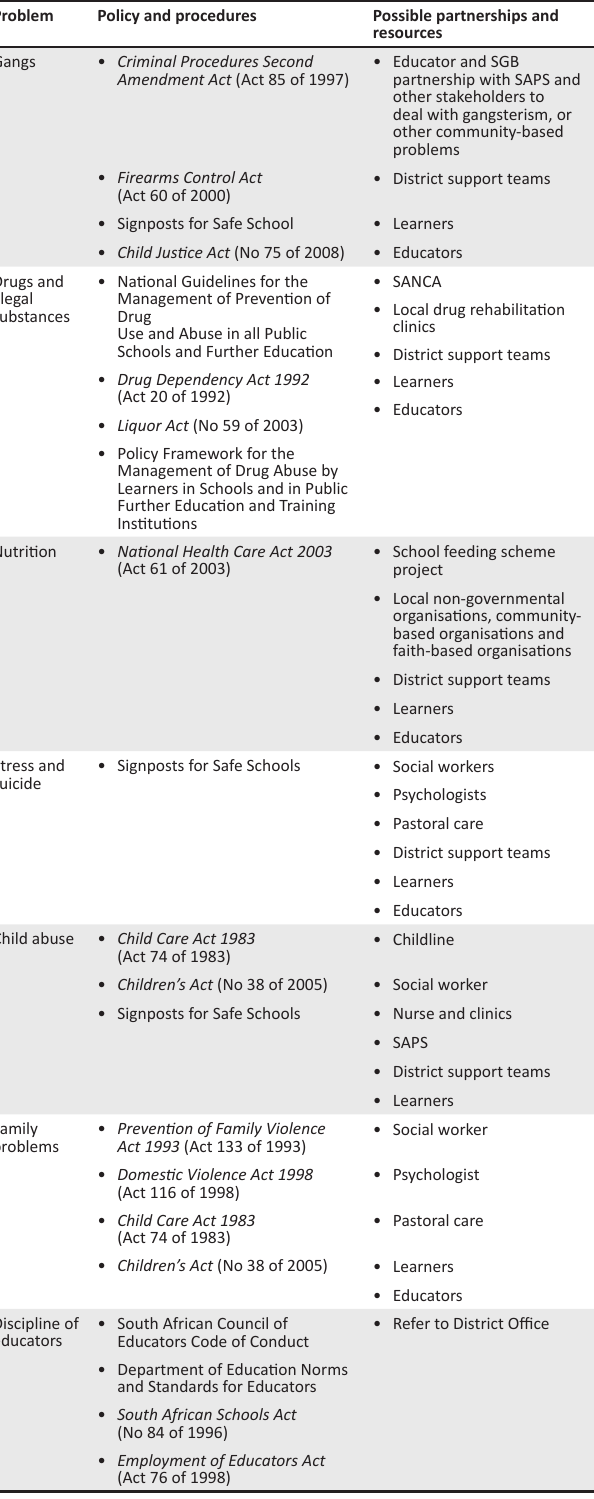
TABLE 1: Summary of South African policies on child well-being and the support resources as per the Integrated School Health Policy.